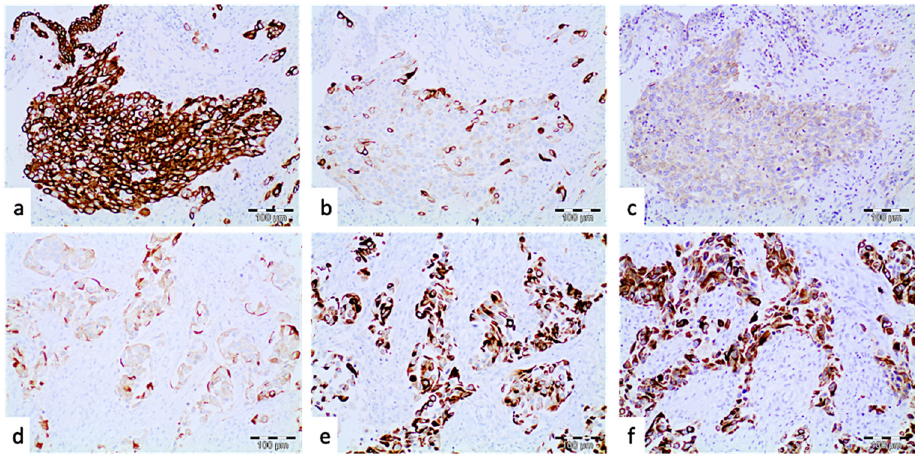
Figure 2. Inmunohistological findings in muscle-invasive urothelial cell carcinoma basal markers ( a – c ). ( a ) Diffuse and strong expression of cytokeratin is shown. ( b ) Cytokeratin 14 showing focal cytoplasmic positivity. ( c ) CD44 cytoplasmic expression in neoplastic urothelial cells. Luminal markers ( d – f ) ( d ) Uroplaquin showing cytoplasmic positivity in neoplastic cells. ( e ) Neoplastic cells with cytoplasmic cytokeratin 20 expression. ( f ) Diffuse and intensive cytoplasmic expression of cytokeratin 18 is shown. (Diaminobenzidine (DAB), 10×).